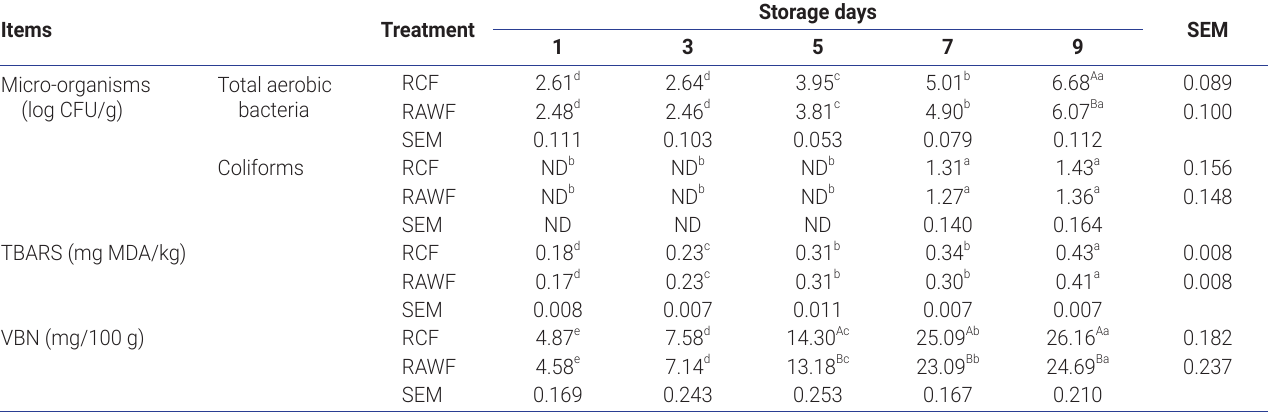
Table 4. Microorganisms, 2-thiobarbituric acid reactive substances (TBARS), and volatile basic nitrogen (VBN) value of thigh meat of Ross 308 broilers from conventional and animal welfare farming system during cold storage Items Treatment Micro-organisms (log